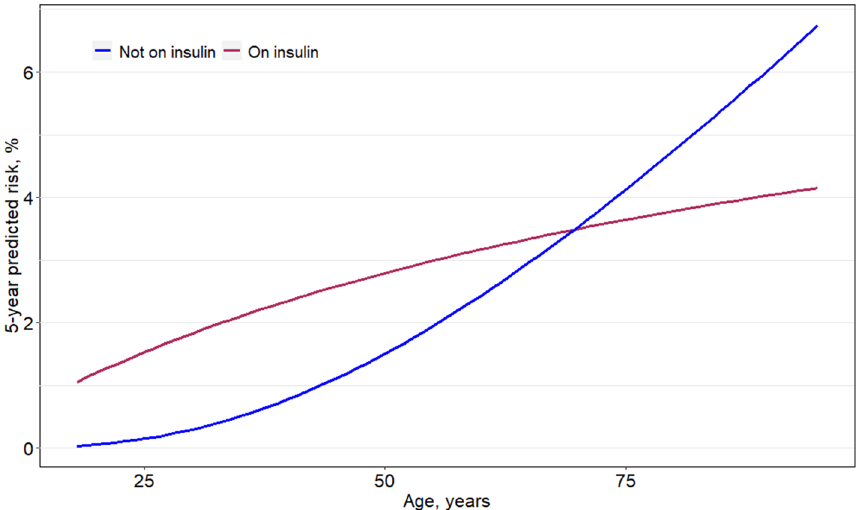
Figure 1. Fractional polynomial terms for age by use of insulin in derived minimal-resources risk model. Interaction effect between age and insulin use in the minimal-resources model, with age modelled as a fractional polynomial term. The y-axis shows the predicted 5-year risk holding all other covariates at the reference value.